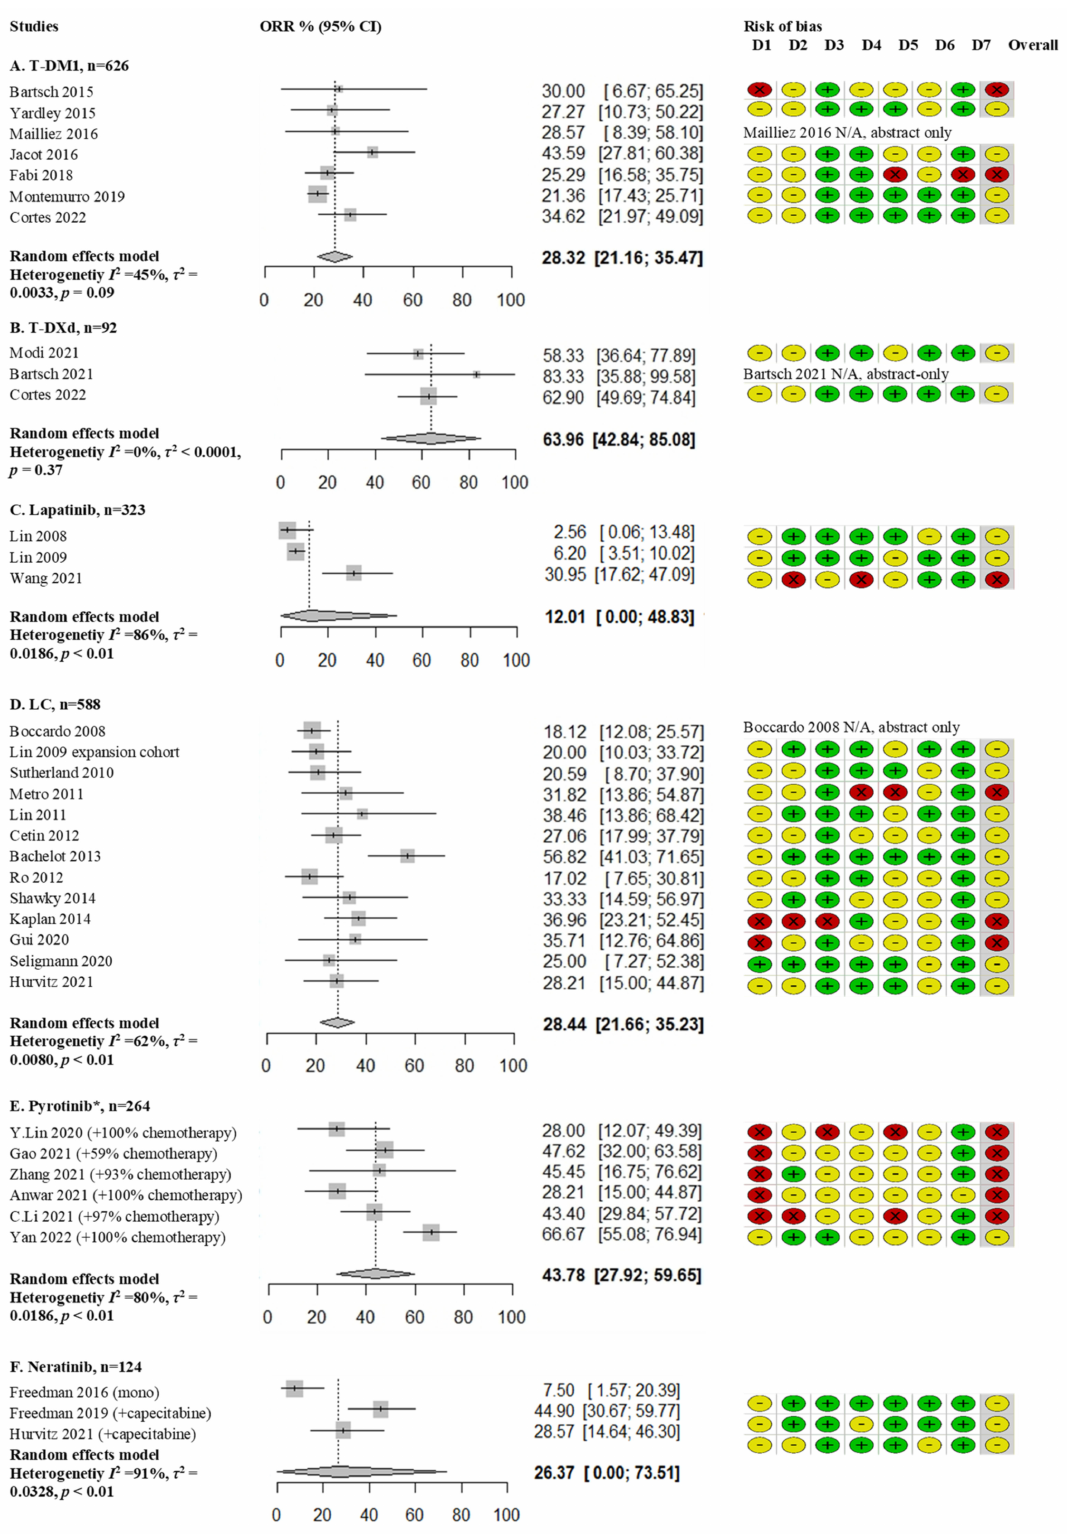
Figure 2. Pooled ORR meta-analysis per drug (combination) and quality assessment of risk of bias ( A ) Trastuzumab-emtansine (T-DM1); ( B ) Trastuzumab-deruxtecan (T-DXd); ( C ) Lapatinib; ( D ) Lapatinib + capecitabine (LC); ( E ) Pyrotinib; ( F ) Neratinib; * amount of patients receiving combi- nation therapy with chemotherapy, mostly capecitabine (see Table